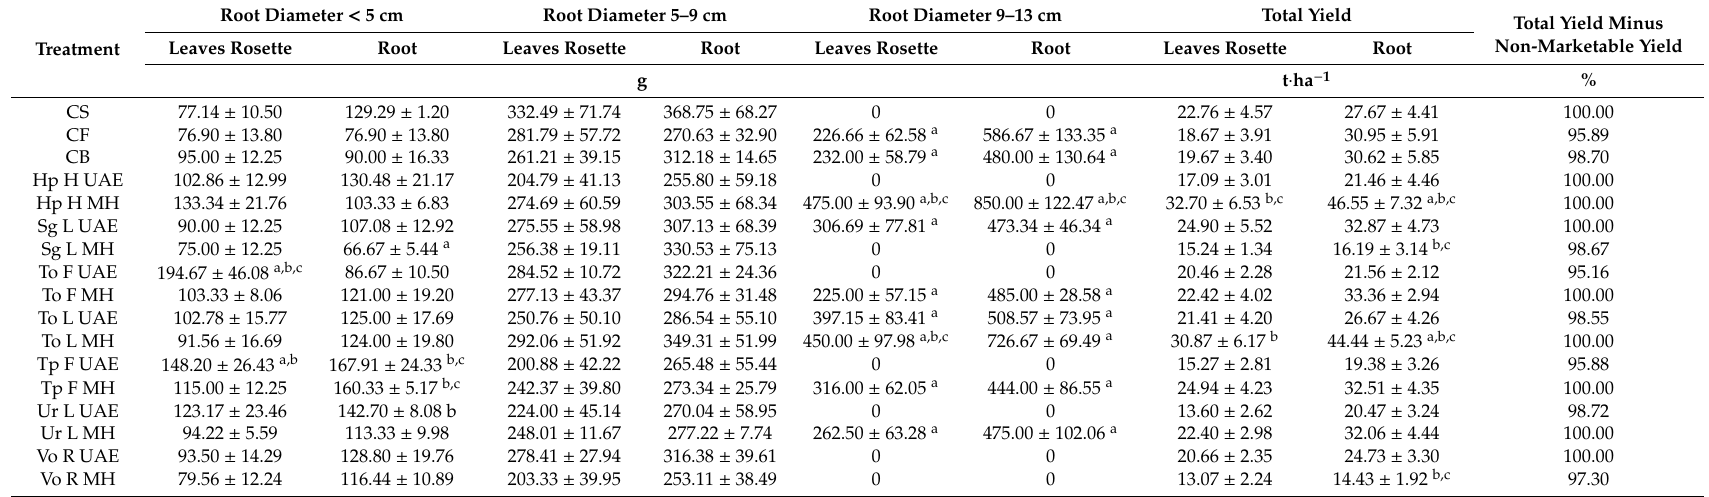
Table 1. E ff ect of the foliar application of botanical extracts on the fresh weight of leaves rosette and root and the total yield of celeriac (N = 3 *, mean ± SD).